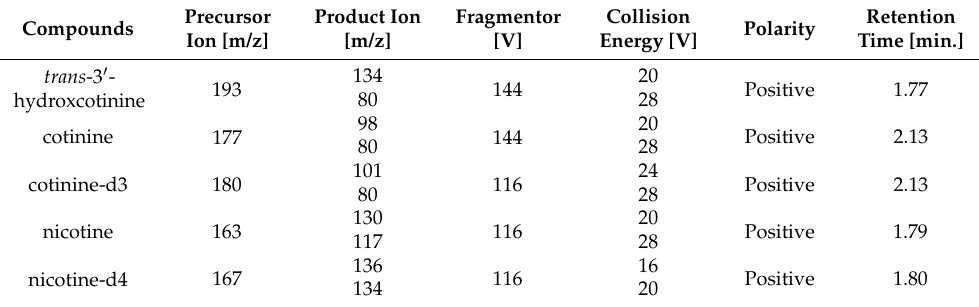
Table 6. ESI-MS/MS parameters and retention time for selected